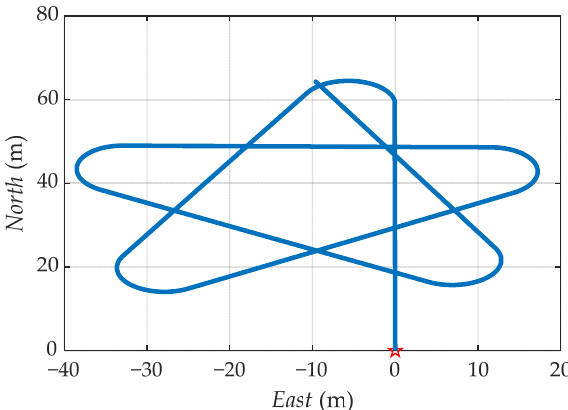
Figure 10. The simulation sets the original trajectory.